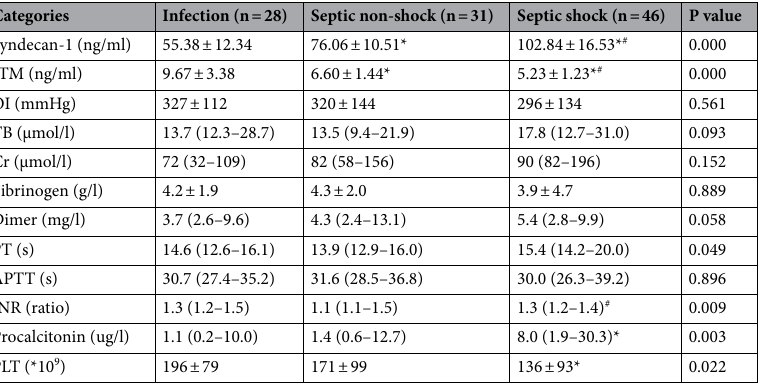
Table 2. Clinical characteristics. Data was presented by mean standard deviation. For normally distributed data, comparisons among multiple groups were conducted by one-way analysis of variance, and those between two groups were carried out with the Least Significant Difference (LSD) post hoc test. For data without normal distribution, Post hoc tests and between-group analyses were performed by Mann–Whitney nonparametric tests and Bonferroni corrected. sTM serum thrombomodulin, OI oxygen index, TB total bilirubin, Cr creatinine, PT prothrombin time, APTT activated partial thromboplastin time, INR International Normalized Ratio, PLT platelet. *P < 0.05 for the comparison between infection and septic non-shock, between infection and septic shock. # P < 0.05 for the comparison between septic non-shock and septic